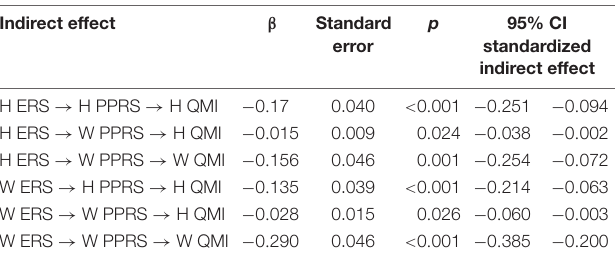
TABLE 3 | Mediating effect analysis